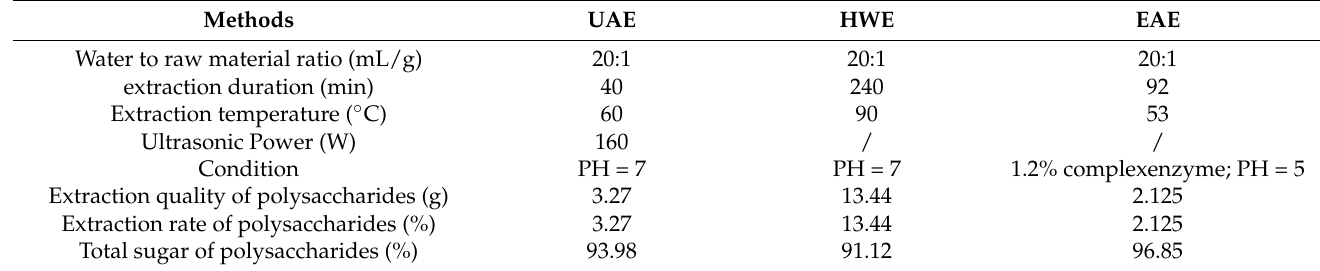
Table 1. Comparison of extraction quality, yield and total sugar of polysaccharides from Atractylodes chinensis (DC.) Koidz. (AKPs) extracted by ultrasound assisted extraction (UAE), hot water extraction (HWE) and enzymatic extraction.